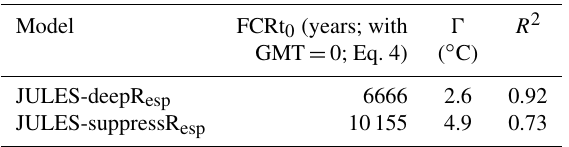
Table 1. Parameters of the exponential fit between permafrost car- bon lost per year per remaining permafrost carbon and global mean temperature change (GMT).